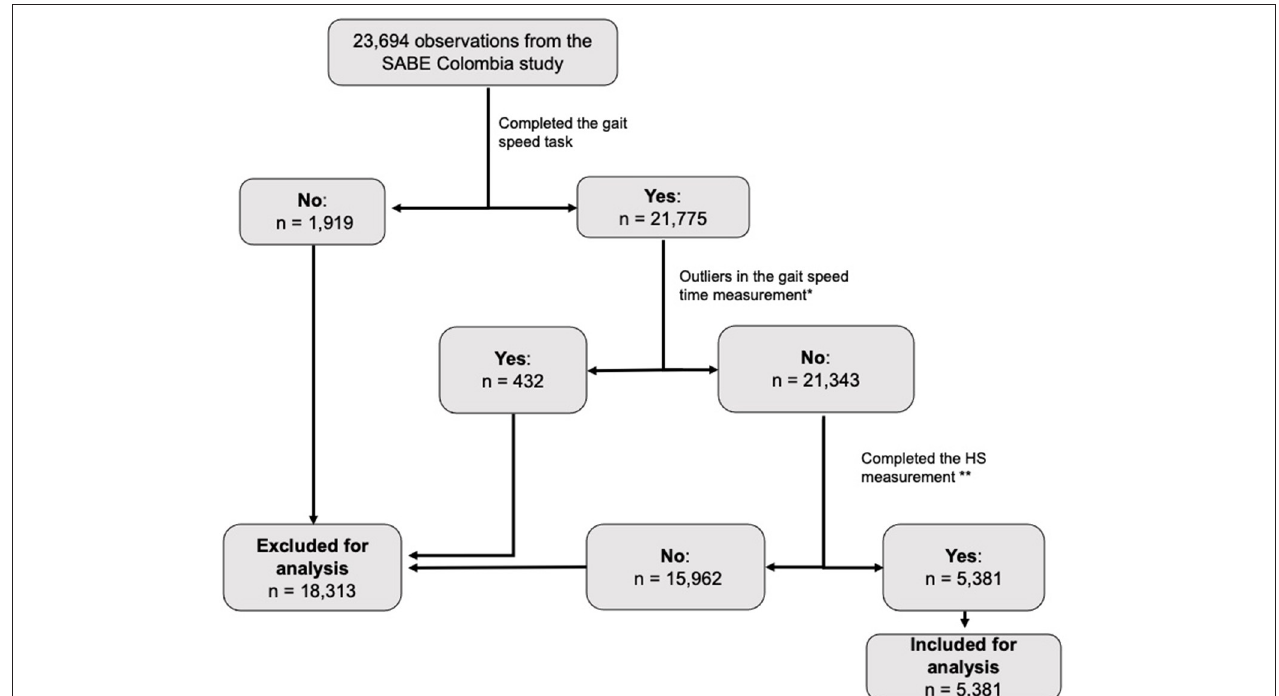
FIGURE 1 | Flow-chart of the exclusion process before the statistical analysis. *Values below the p1 and above the p99 on the time spent wqalking 3m were excluded from the analysis. **HS, Handgrip strenghth (only a subsample were indicated to use the an adjustable digital handgrip dynamometer).